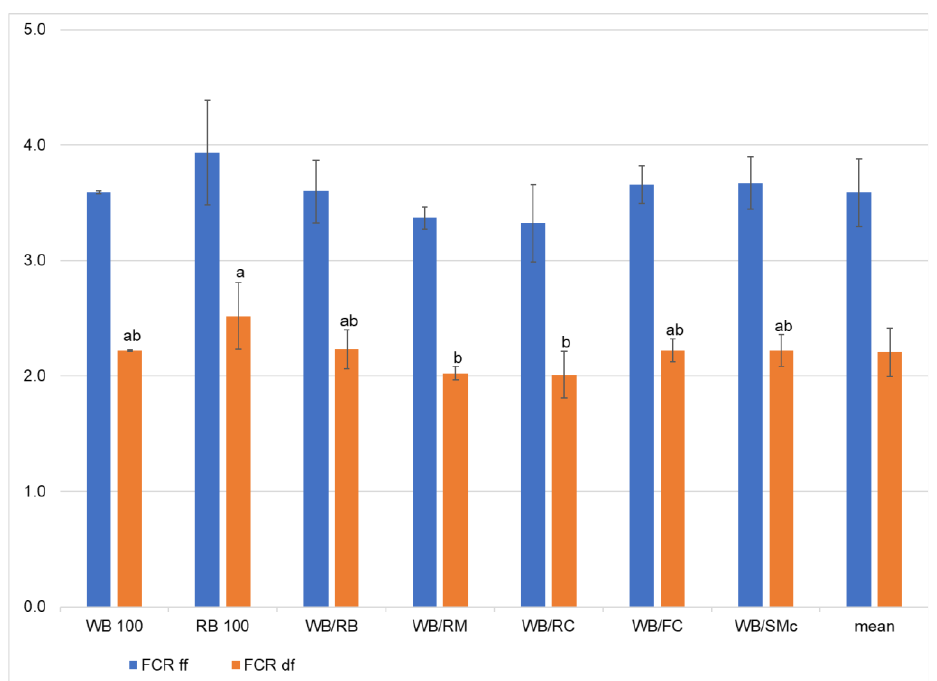
Figure 1. Feed-conversion ratio (FCR) on the fresh (ff) and dry matter basis (df), depending on the diet; WB (wheat bran), RB (rye bran), WB/RB (wheat bran/rye bran), WB/RM (wheat bran/rapeseed meal), WB/RC (wheat bran/rapeseed cake), WB/FC (wheat bran/flax cake), WB/SMc (wheat bran and Silybum marianum cake); the letters a, b, c, etc., show statistically homogenous groups (Tukey’s test at p < 0.05); bars represent standard deviation.